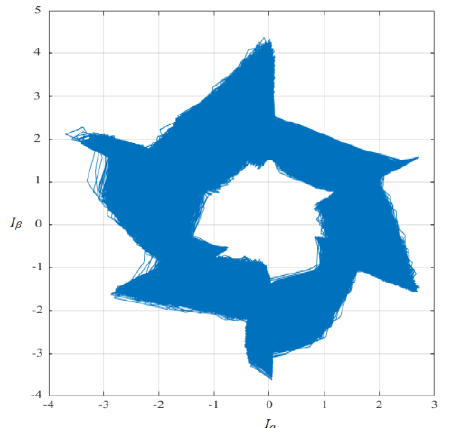
Figure 5. The equivalent current vector hodograph of the failed